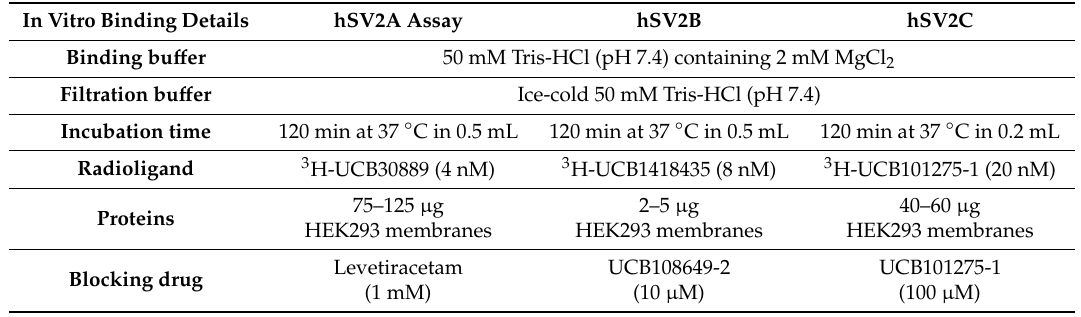
Table 3. Details of the in vitro binding assay determination. Percentage of inhibition was